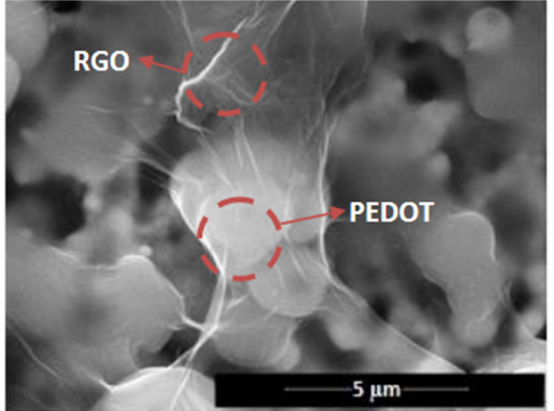
Figure 7. SEM images of rGO (RGO)/PEDOT film and conduction pathway [92], reprinted with permission from